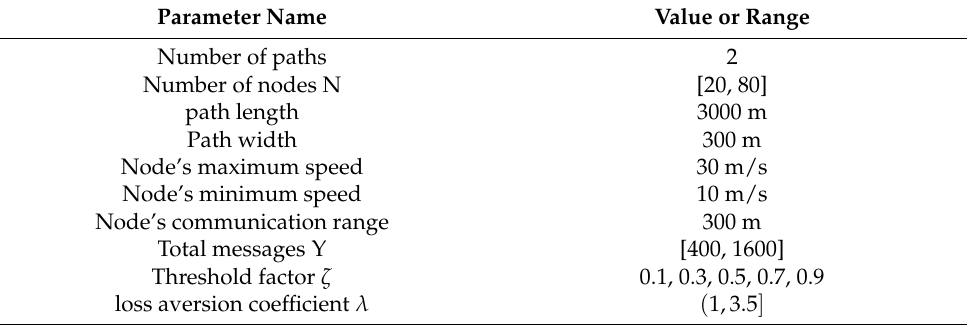
Table 3. Parameters for